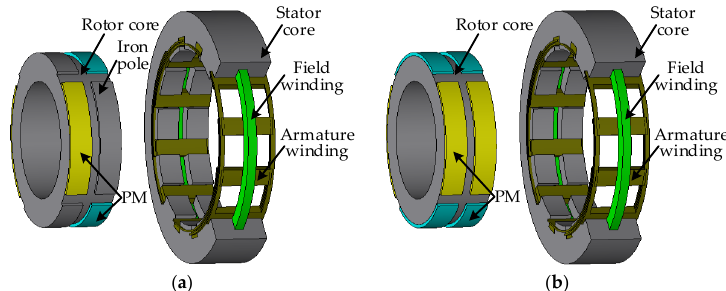
Figure 1. Machine Structure. ( a ) Consequent-pole PM machine. ( b ) PM machine.